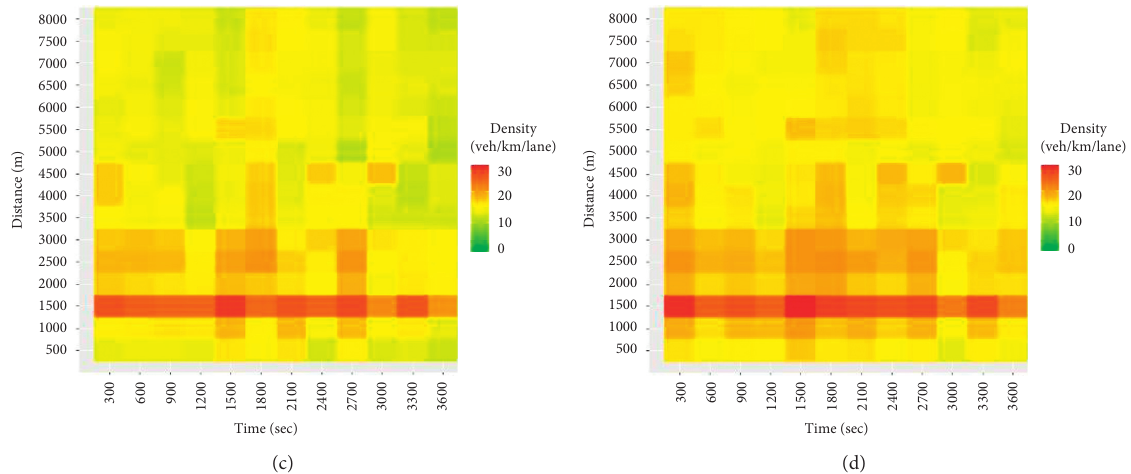
Figure 8: Estimated traffic density by sample rate of scenario 1 (empirical evaluation). (a) Ground truth of traffic density. (b) Estimated density at 10% sample rate. (c) Estimated density at 20% sample rate. (d) Estimated density at 30% sample